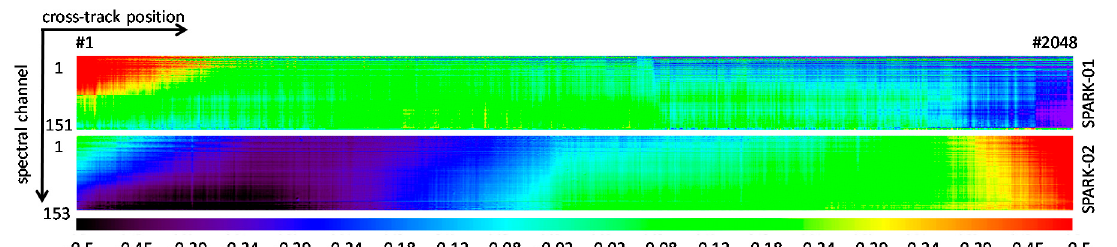
Figure 33. Central wavelength positions measured pre-launch in laboratory for SPARK-01 and -02.